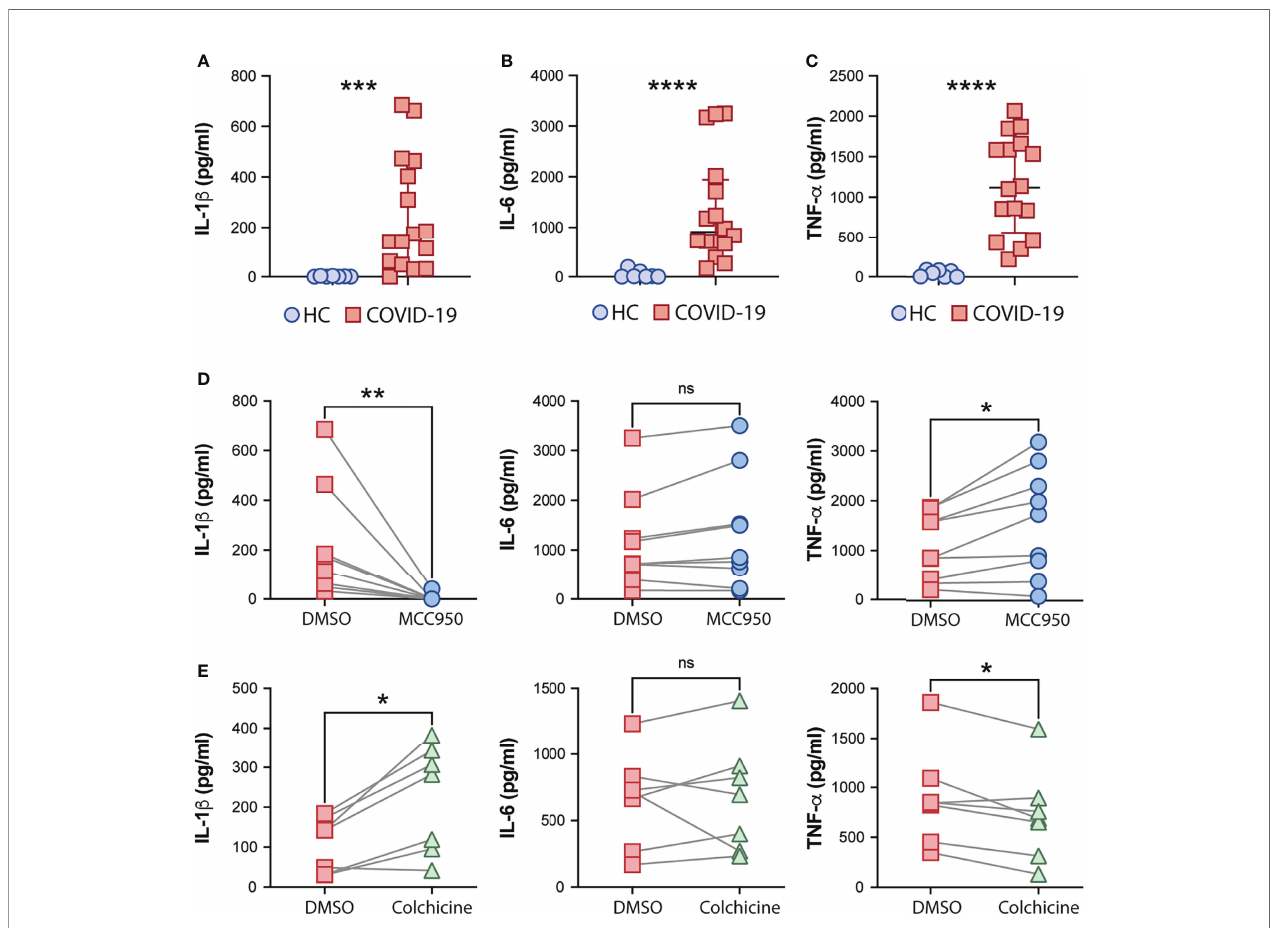
FIGURE 3 | Effects of the NLRP3 inhibitor MCC950 and colchicine on cytokine secretion by COVID-19 PBMCs. IL-1 b (A) , IL-6 (B) and TNF a (C) levels from supernatants of healthy control (HC, n = 7) or COVID-19 patients PBMCs (n = 16) after a 4-hour incubation at 37°C, were determined by multi-analyte fl ow assay kit. Lines represent median values and interquartile ranges. Data were analyzed using the Mann – Whitney test. ***P < 0.001, ****P < 0.0001. Alternatively, COVID-19 cells were treated with the NLRP3 inhibitor, MCC950 (10 m M; n = 9) (D) or colchicine (10 m M; n = 7) (E) during the incubation period, and cytokine levels were measured in the culture supernatants. Numbers represent the median values and interquartile ranges with or without treatment. Paired analysis was performed using the Wilcoxon test. *P < 0.05; **P < 0.01; ns , not signi fi